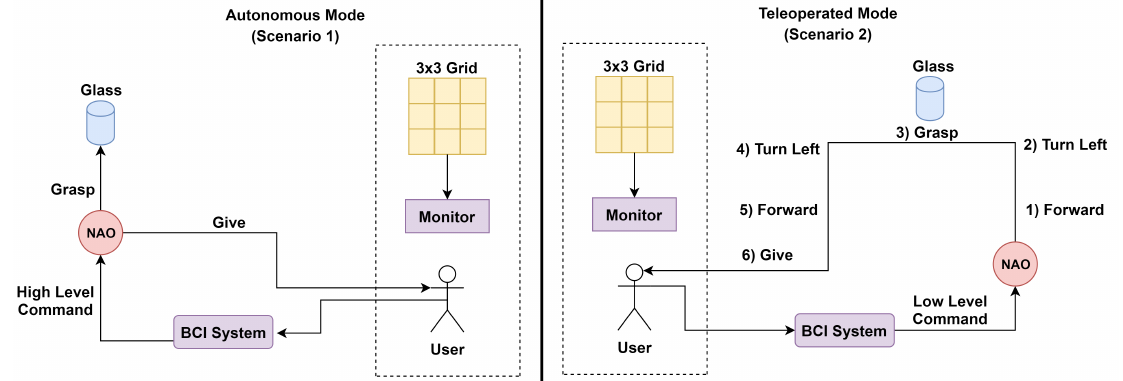
Figure 7. Autonomous and teleoperated mode (adapted from: